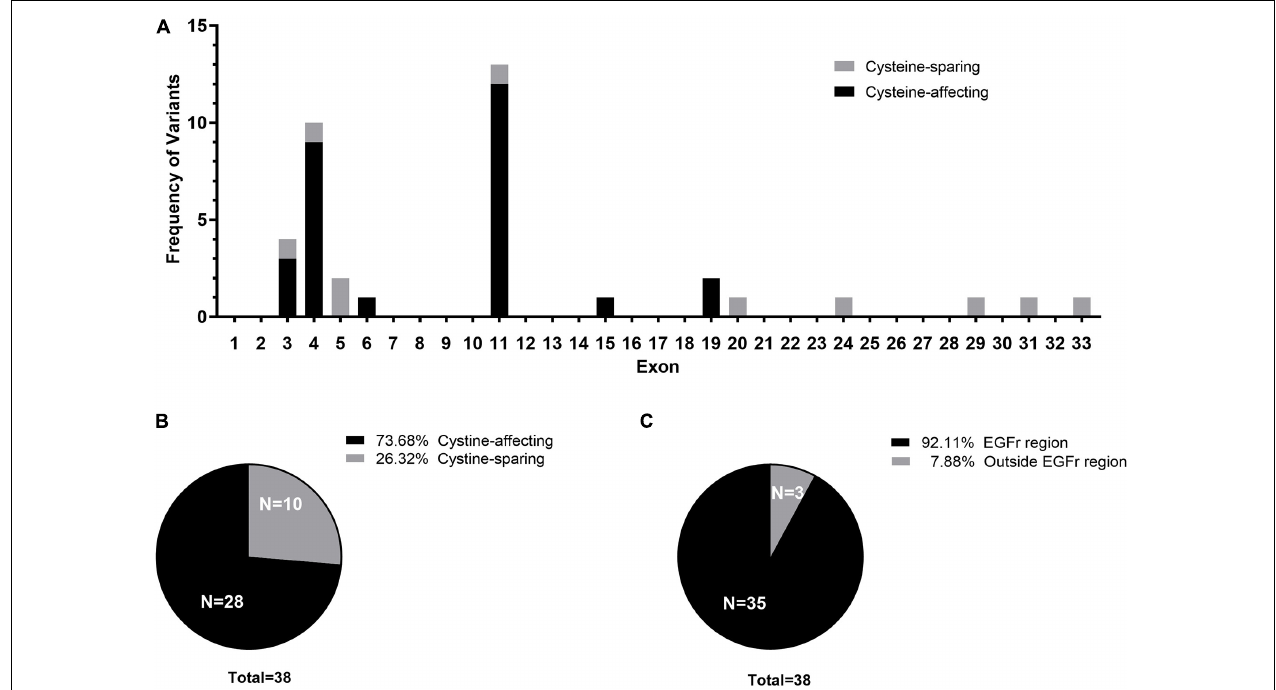
FIGURE 1 | (A) Exon distribution of the cysteine-affecting and cystine-sparing NOTCH3 variants identified in 38 patients. (B) Pie chart displaying the proportion of patients carrying cystine-affecting variants and cystine-sparing variants. (C) Pie chart displaying the proportion of patients carrying NOTCH3 variants within EGFr region and outside EGFr